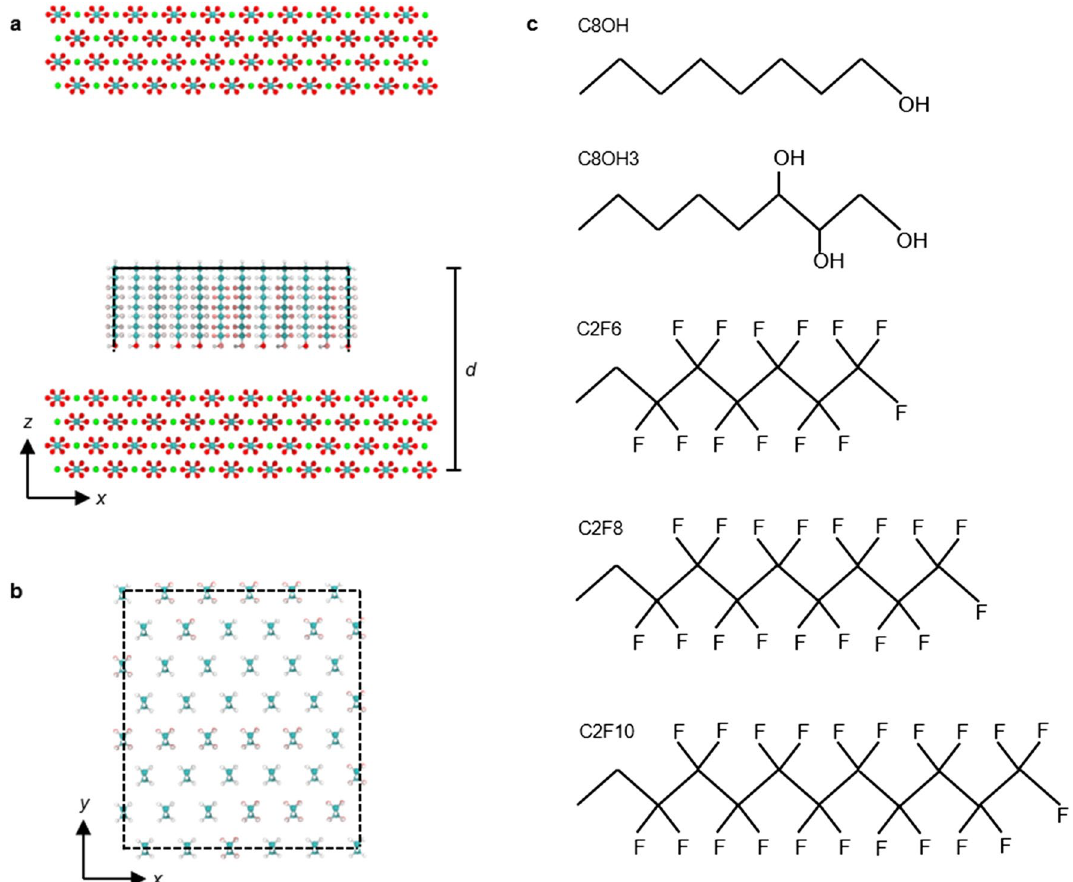
Figure 1. Simulation setup. ( a ) Side view of a bicomponent alkanol and fluoroalkane self-assembled monolayer − 1 4) surface separated with distance d . ( b ) Top view of the SAM with the alkanols and (SAM) on a calcite (1 0 fluoroalkanes grafted onto a hexagonal lattice. The atom colors were: C = cyan, H = white, O = red, Ca = green, and F = pink. ( c ) Chemical structures and abbreviations of all the SAM molecules used in this